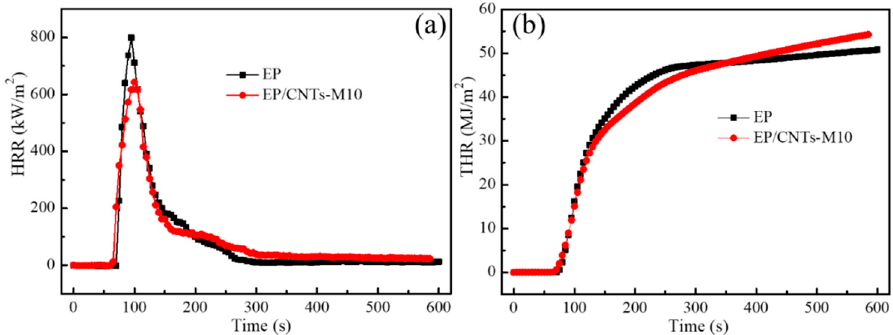
Figure 6. Heat release rate ( a ) and total heat release ( b ) versus time curves of EP and EP/CNTs-M10.